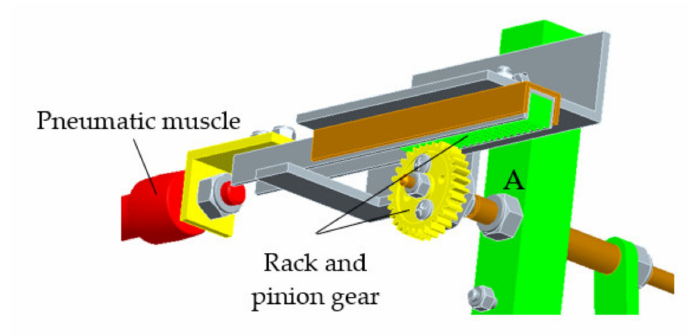
Figure 7. Actuation of the rehabilitation